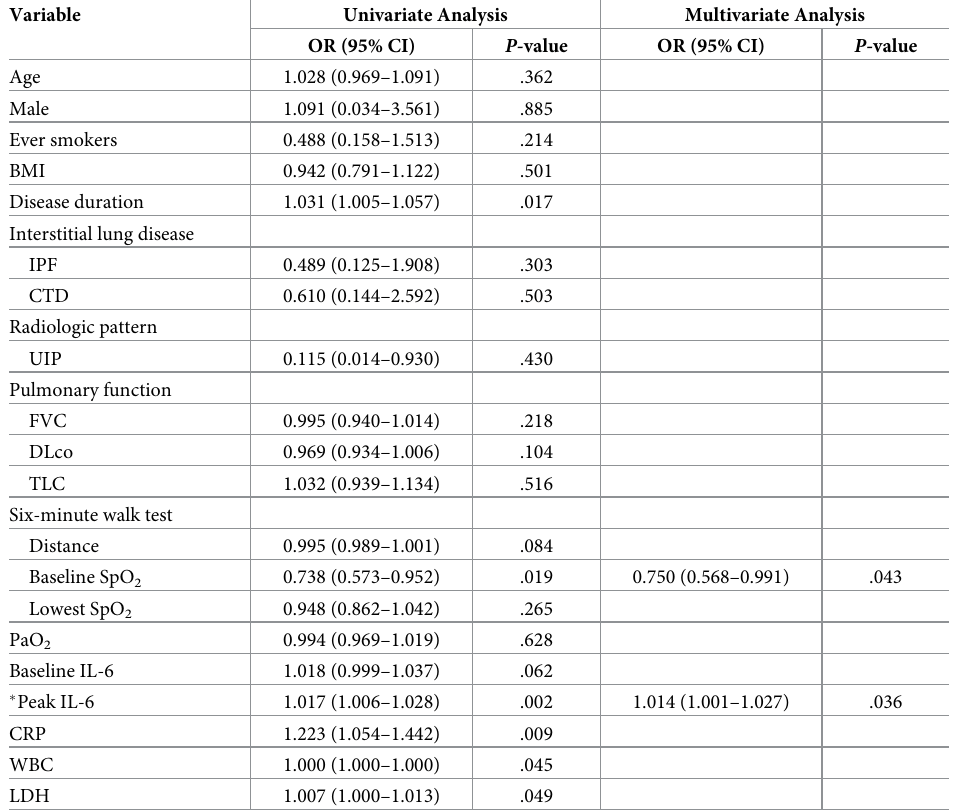
Table 3. Predictive factors for AE in ILD patients assessed using the logistic regression